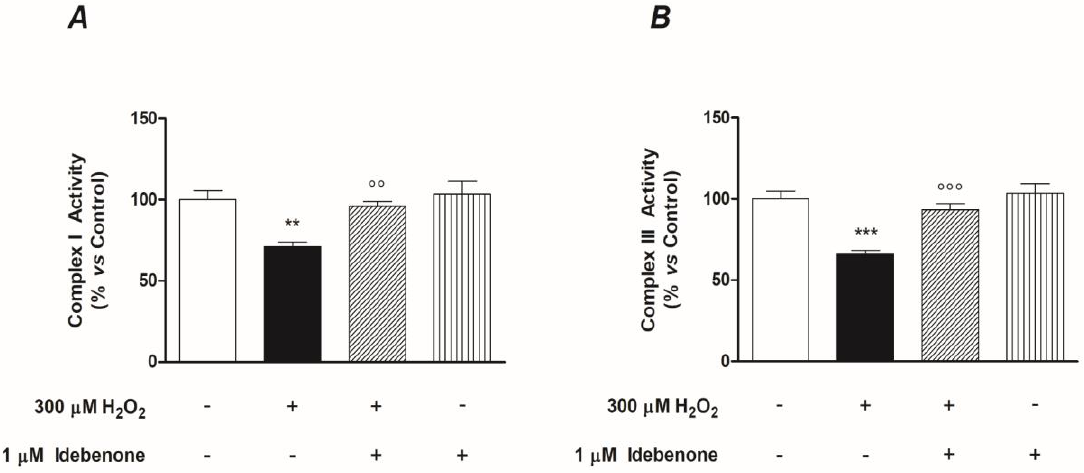
Figure 6. Idebenone supports the functions of mitochondrial respiratory chain complexes (I and III). The graphs show the ability of the idebenone pre-treatment (24 h) to restore complex I ( A ) and complex III ( B ) mitochondrial respiratory functions, which were depressed after oxidative stress induced by 24 h of treatment with H 2 O 2 . Both graphs are the result of two independent experiments performed in quintuplicate ( n = 10/group). The results are expressed as a percentage of the untreated control (control = 100%). Results are from two independent experiments, the means ± SEM of 10 replicates per group. ** p < 0.01 and *** p < 0.001 vs. control; °° p < 0.01 and °°° p < 0.001 vs. H 2 O 2 alone.